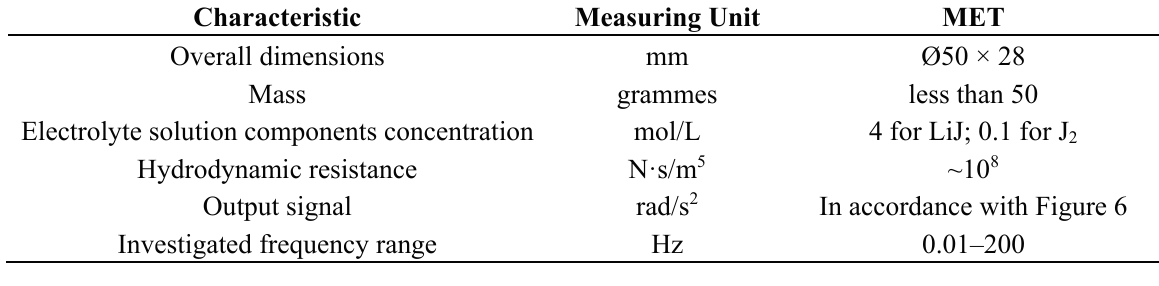
Table 1. Structural characteristics of the studied angular motion sensors.